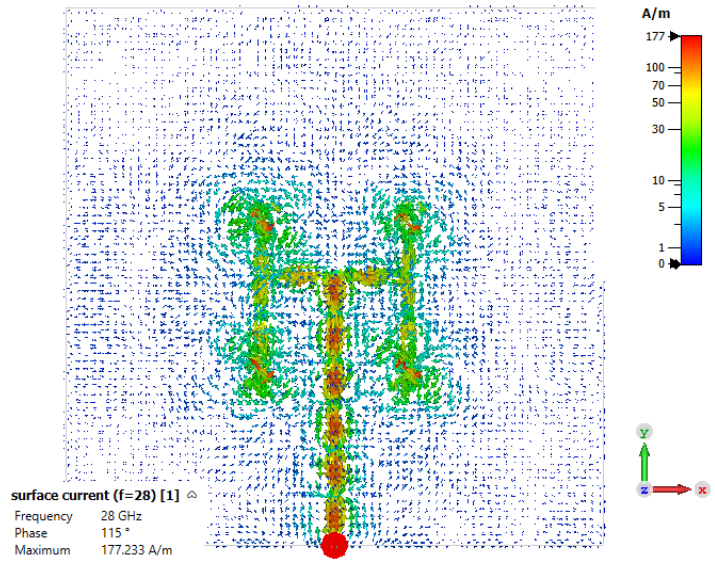
Table 4. The average SAR for 1-gram and 10-gram tissues using input power of 15 dBm, 18 dBm and 20 dBm. Figure 14. Surface-current distribution on the DRA array’s ground plane at 28 GHz.